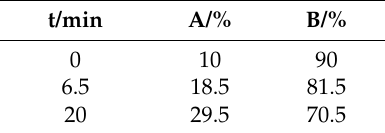
Table 3. Flow phase gradient elution program.